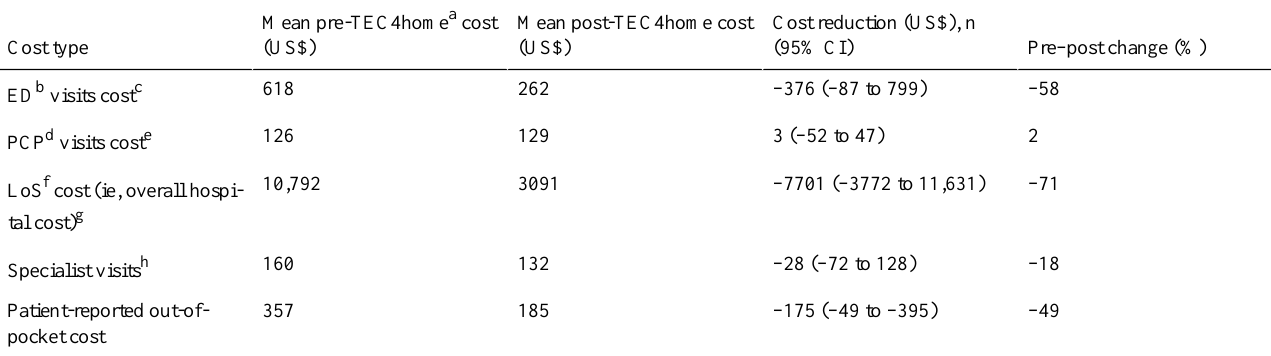
Table 2. Per-patient aggregate health care utilization